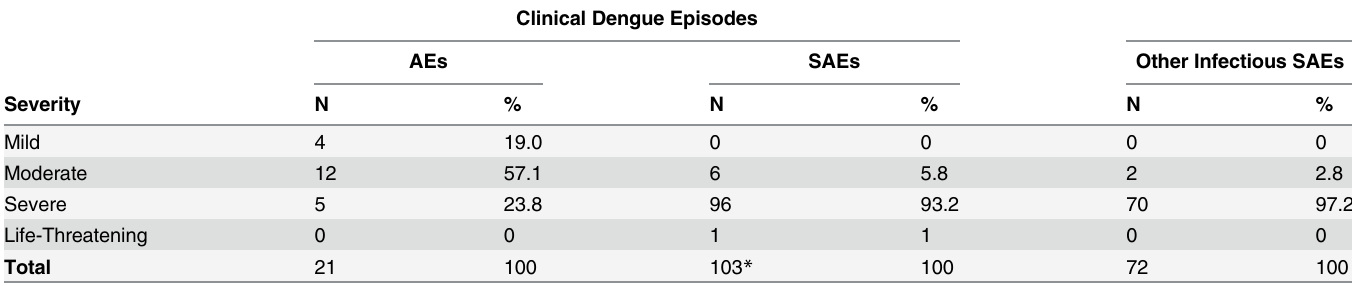
Table 2. Distribution of the Adverse Events (AEs) and Serious Adverse Events (SAEs) for Clinical Dengue Episodes and Other Infectious SAEs During RV144.